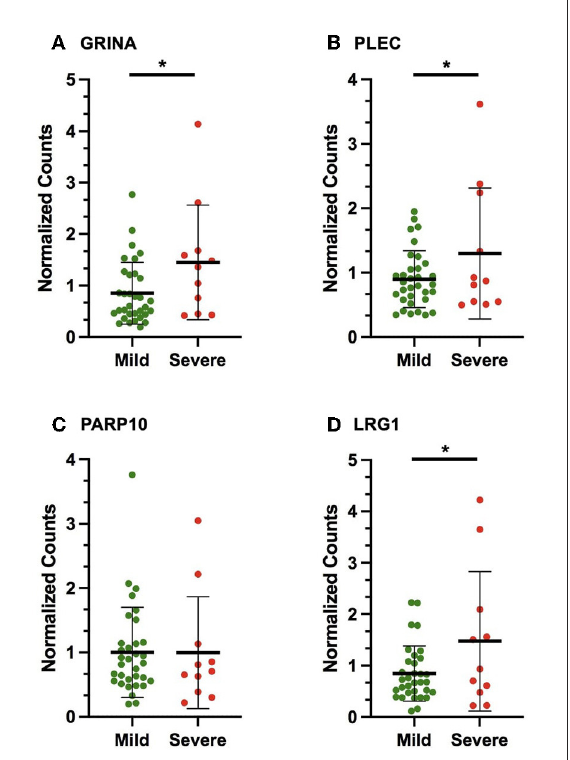
FIGURE2 Scatter plots displaying the number of gene copies normalized to the expression of HPRT1 and B2M (normalized counts) in the validation cohort for the following VSE-MS-linked candidates: (A) GRINA, (B) PLEC, (C) PARP10, (D) LRG1. The mean and standard deviation are shown. The asterisks (*) indicate statistically significant results ( p < 0.05).